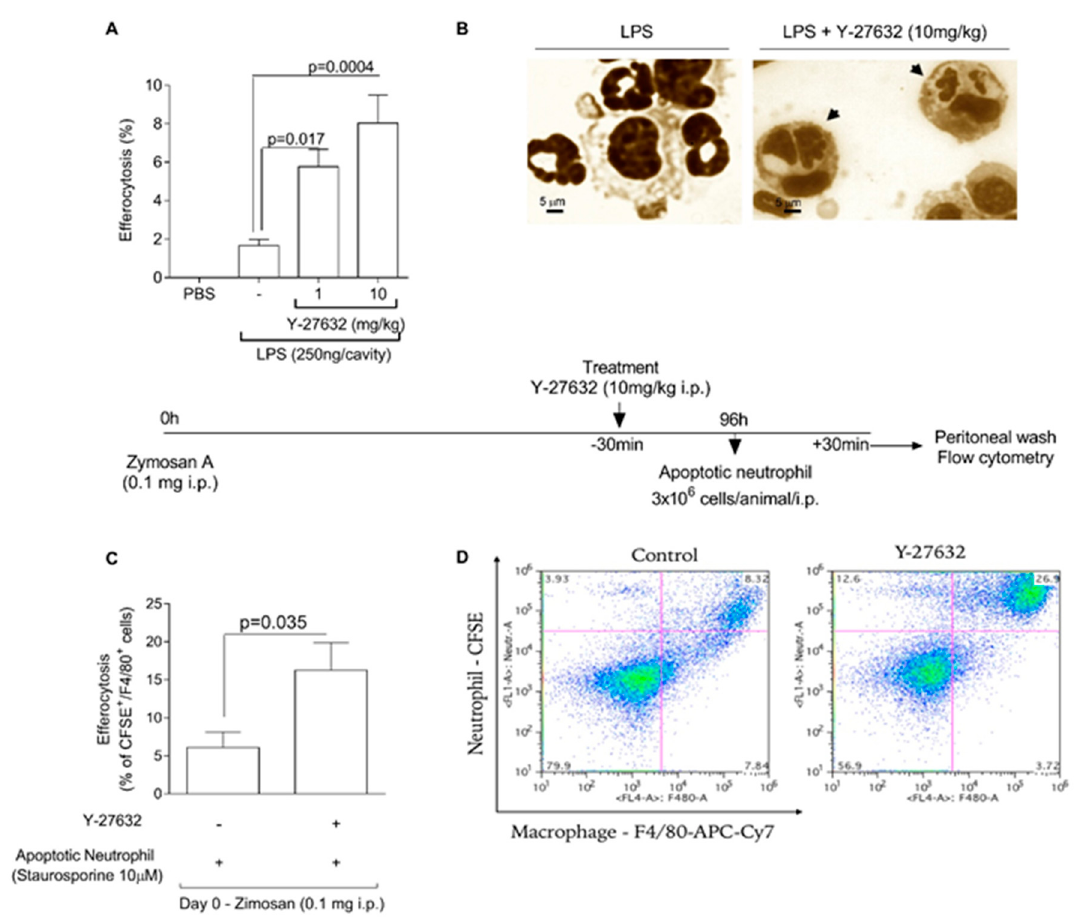
Figure 3. Y-27632 enhance e ff erocytic capacity of murine macrophage. Mice were injected with PBS or LPS (250 ng / cavity, i.pl.) and, 4 h later, received a local injection (i.pl.) of Y-27632 (1 or 10 mg / kg, i.pl.) or vehicle. Apoptotic cells inside macrophages were evaluated 4h after drug treatment. Results are expressed as percent of apoptotic neutrophils ingested by macrophages ( A ) Representative figure of viable neutrophil and macrophage in untreated mice and apoptotic neutrophil inside mononuclear cell (arrowhead) in animal treated with Y-27632 ( B ). Scale bar = 5 µ m. Original magnifications, × 40. Human neutrophils were isolated by histopaque gradient, and were incubated with staurosporine to induce apoptosis and fluorescently labeled with carboxyfluorescein succinimidyl ester (CSFE). Apoptotic neutrophils were injected (i.p) into mice bearing a 96-h peritonitis elicited by 0.1 mg of zymosan. ROCK inhibition (i.p.) was induced 30 min before apoptotic neutrophils injection. 30 min later cells were collected by peritoneal lavage and e ff erocytosis were evaluated by flow cytometer. Mice that received only apoptotic neutrophils were considered control group. Data were collected with BD Accuri ™ C6—Flow Cytometry and analyzed with FlowJo software. Results are expressed as percent of double-positive cells for CFSE and F4 / 80 ( C ). Representative dotplots are shown ( D ). Results are shown as the mean ± SEM of five mice in each group (Student t